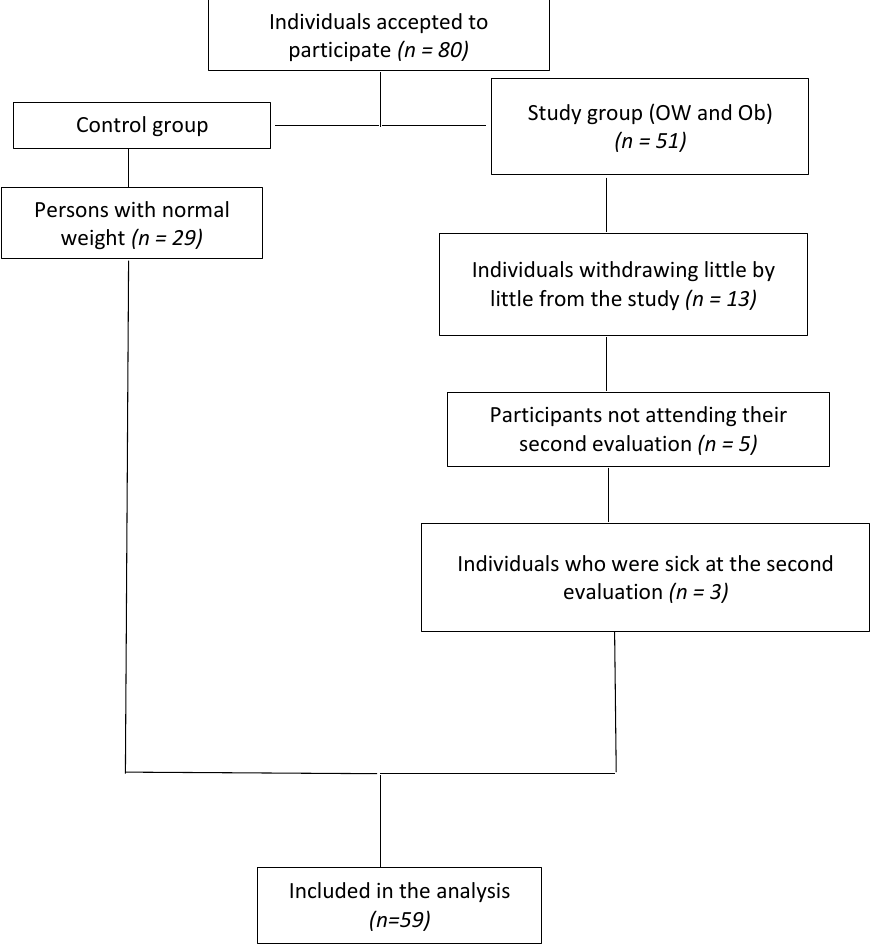
Figure 1. Distribution of the population along the study